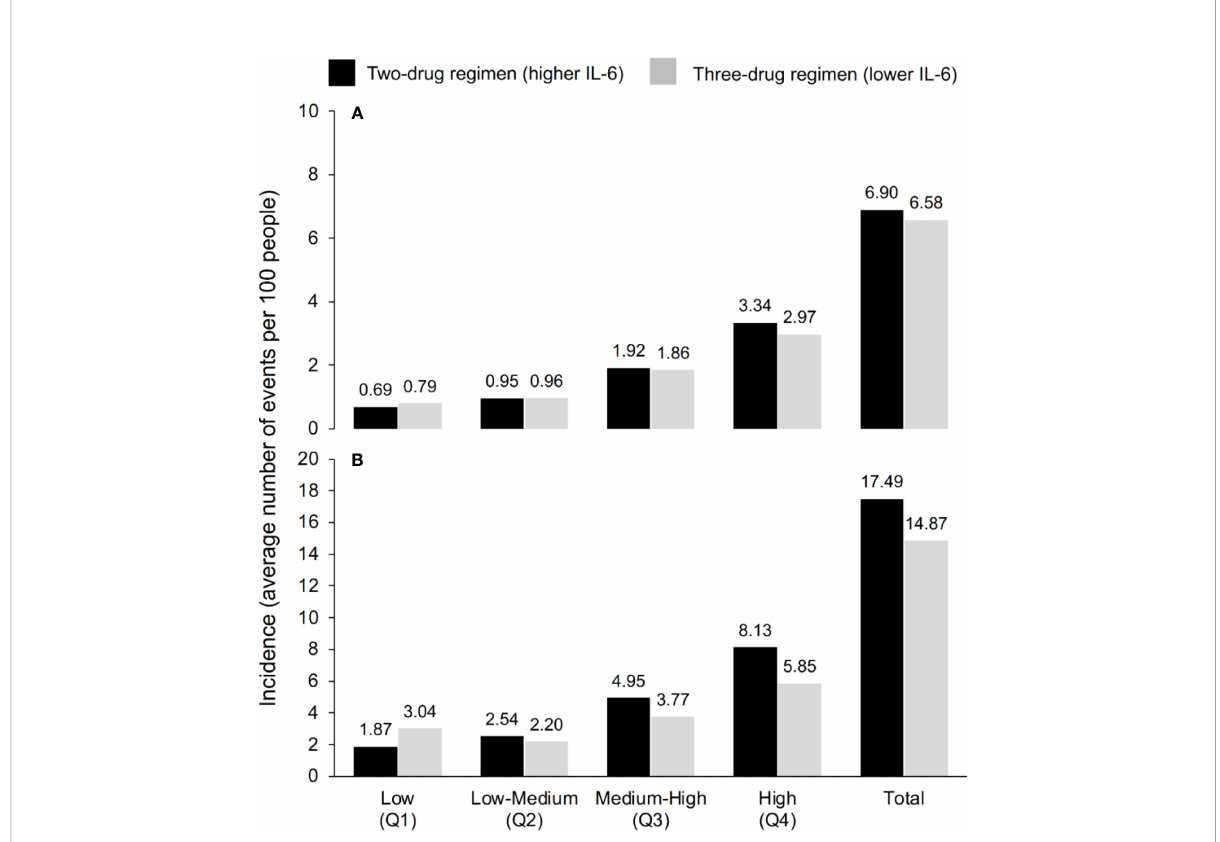
FIGURE 2 Incidence of serious non-AIDS events (cardiovascular, hepatic or renal event, or malignancy) or all-cause death according to IL-6 quartile and ART regimen over (A) 3 years and (B) 5 years, according to the model, which used the IL-6 trajectories seen in TANGO (n=741, up to Week 144) and AIR (n=148, Weeks 144 –